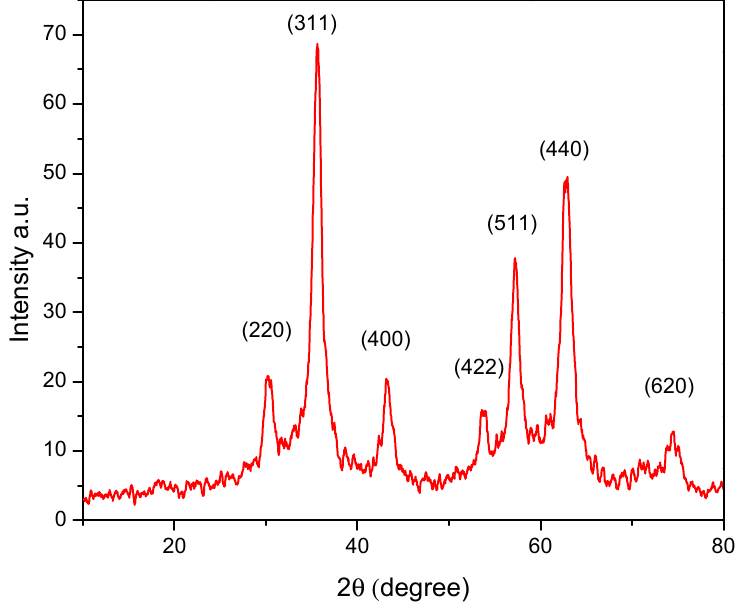
Figure 1. XRD pattern of Fe 3 O 4 @Tre NPs.